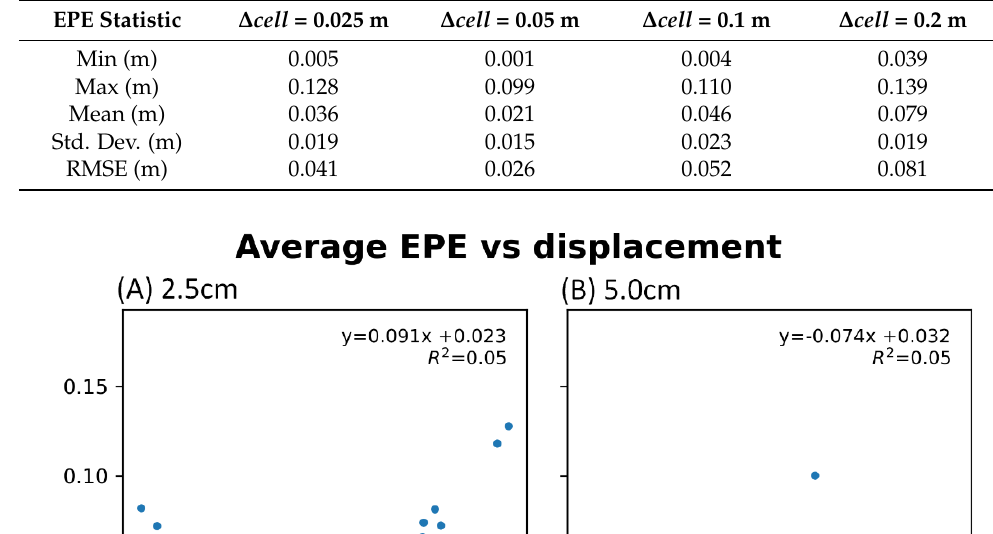
Table 4. 2D Accuracy of SlideSim using various cell sizes ( ∆ cell ) of the input model to compute landslide displacement reported as EPE (end-point error) in meters compared to ground truth points. EPE Statistic ∆ cell = 0.025 m ∆ cell = 0.05 m ∆ cell = 0.1 m ∆ cell = 0.2 m